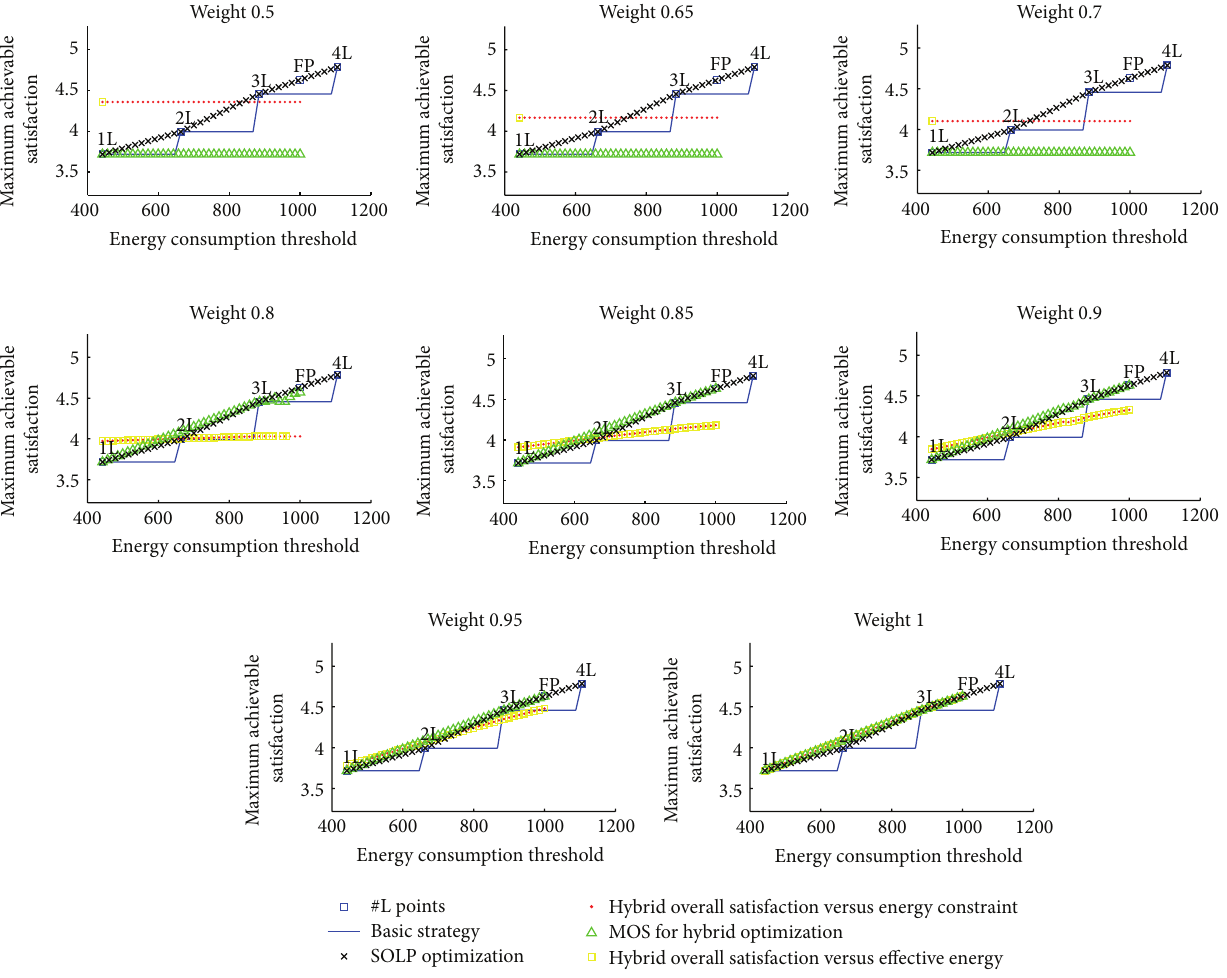
Figure 10: Evolution of optimization strategies with 0.5 ≤ 𝑤 ≤ 1 in the objective